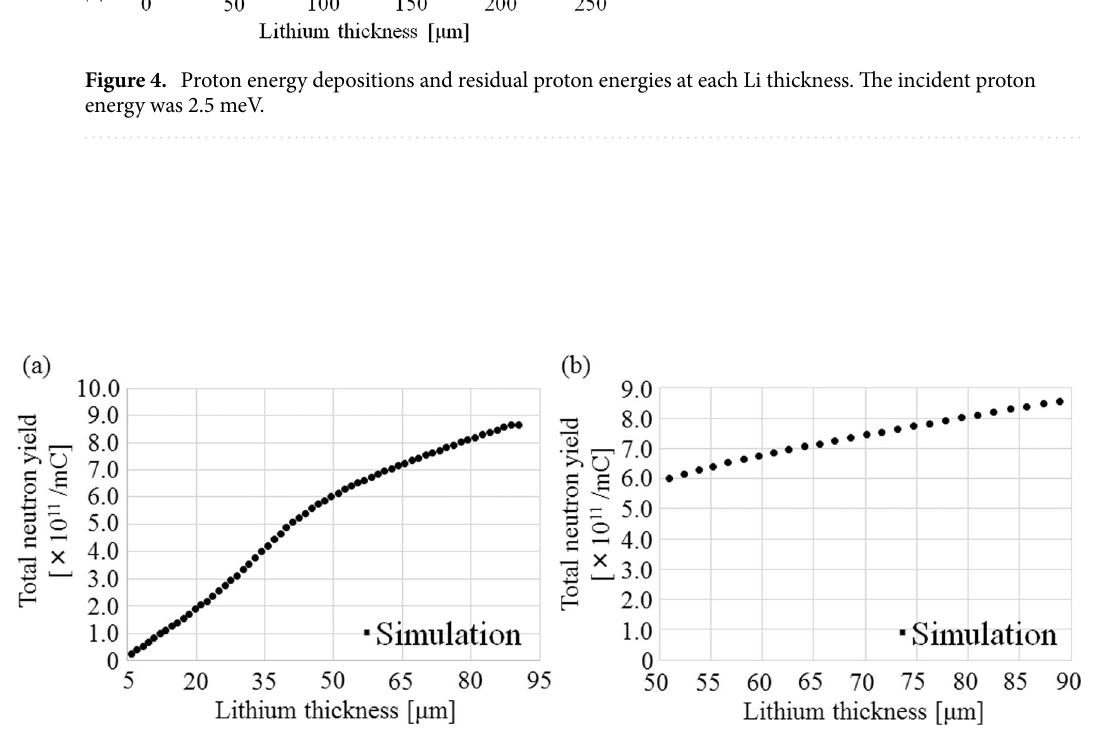
Figure 5. ( a ) Total neutron yield as a function of Li thickness on the Li target. ( b ) Total neutron yield versus the Li thickness in the range from 50 to 90